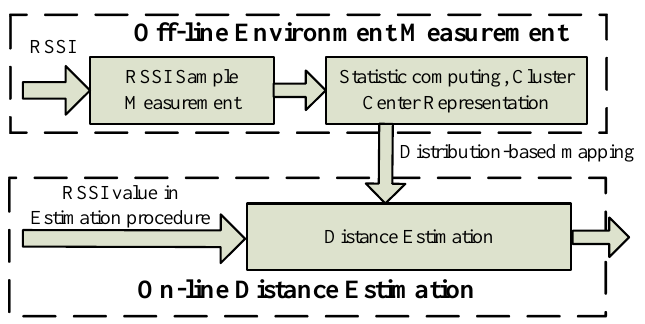
Figure 1. The framework of